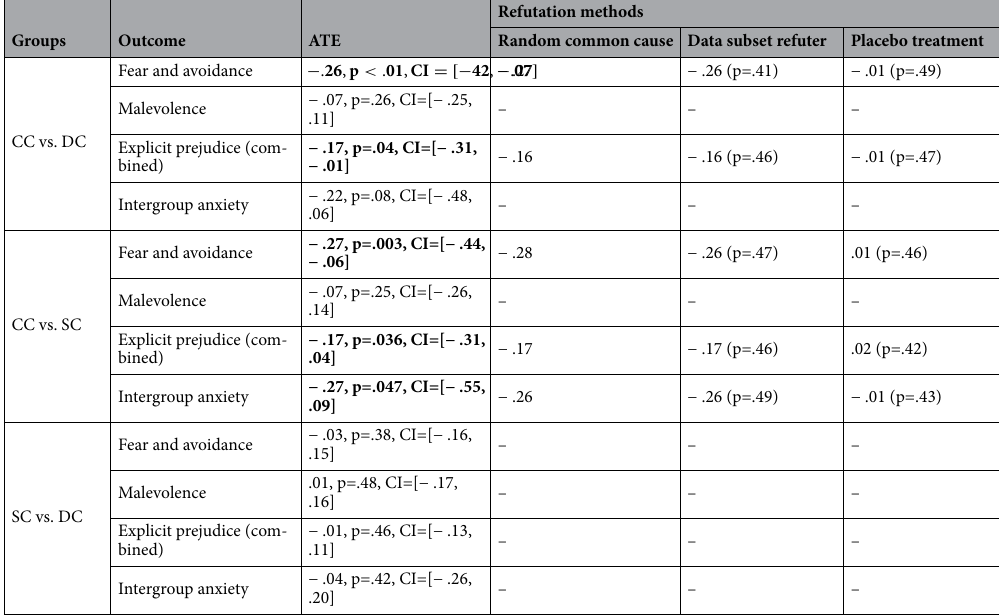
Table 3. ATE for explicit prejudice measures and intergroup anxiety, and results from different refutation methods. p > .05 in the refutation methods supports the validity of the effects